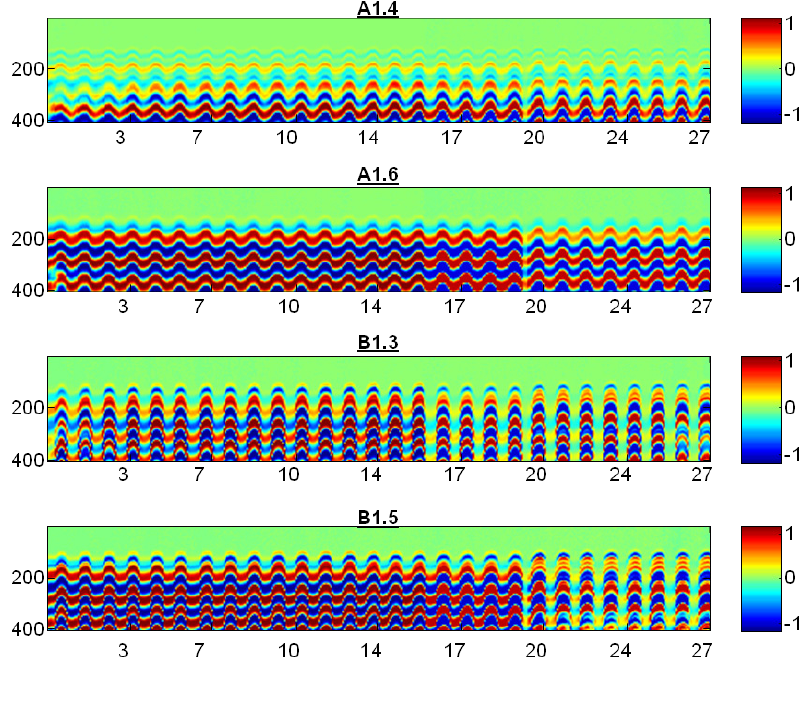
Figure 15. B-scan images of concrete specimens along of the